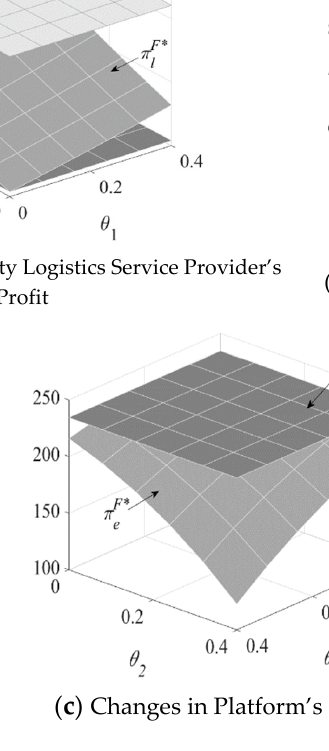
Figure 5. Changes in decision-maker’s profits with θ 1 and θ 2